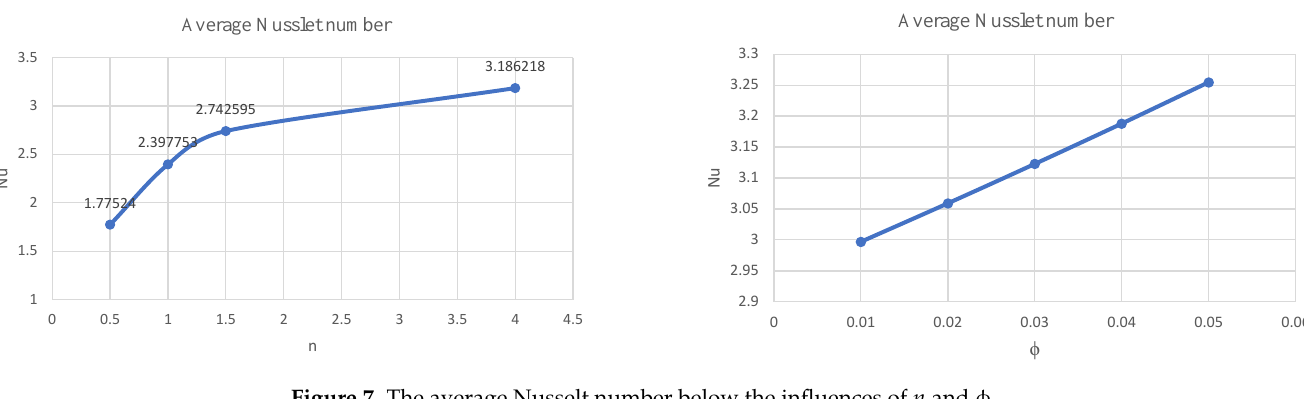
Figure 8. The influence of an inner superellipse shape enclosures on the vertical velocities and temperature profiles. 4. Conclusions In this paper, using the FVM method, we scrutinized the influences of superellipse inner shapes on the nanofluid movements in a non-Darcy porous cavity. The hot superel- lipse inner shapes were placed at the cavity ’ s bottom and top. The cavity ’ s boundary con- ditions were considered as adiabatic boundaries on the top and bottom. The investigations led to the following conclusions: •